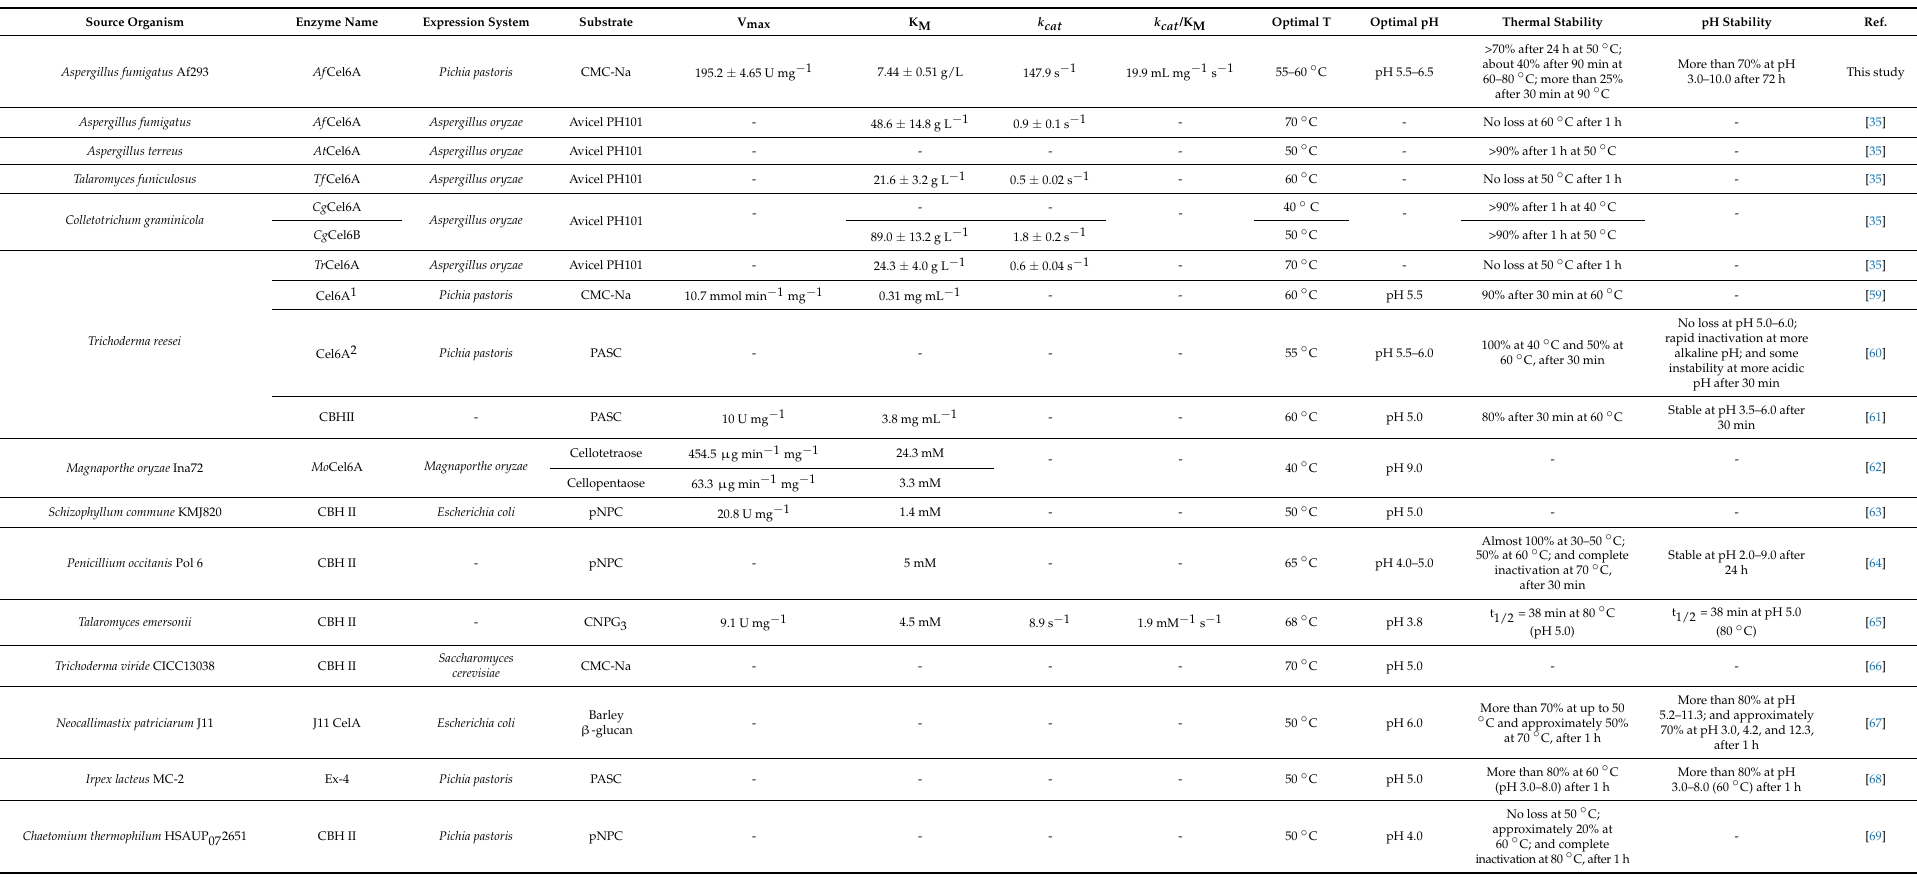
Table 2. Comparison among catalytic and biochemical properties of GH6